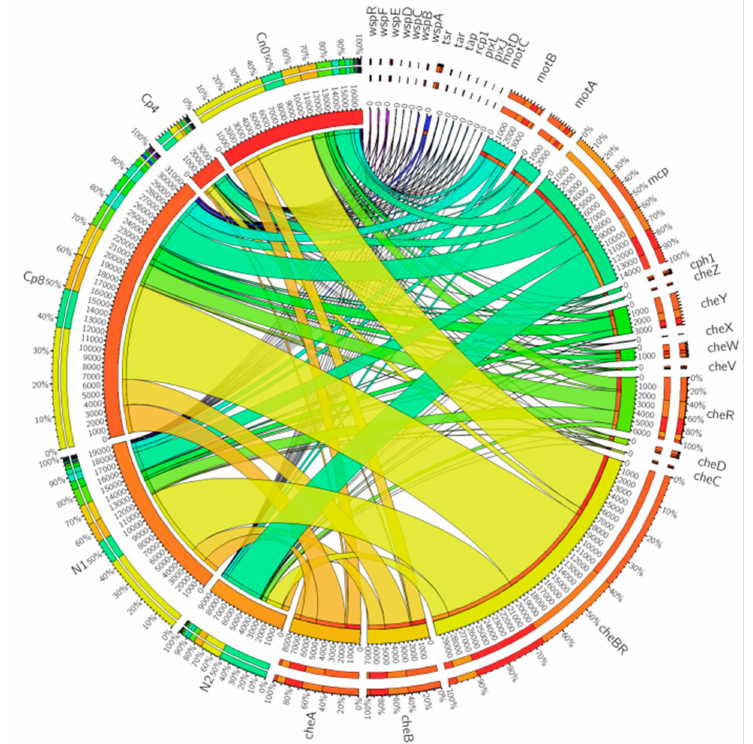
Figure 2. The distribution of chemotaxis genes in maize rhizosphere soil samples under fertilization and control conditions. Cn0 (control), Cp8 (8 tons/ha compost manure), Cp4 (4 tons/ha